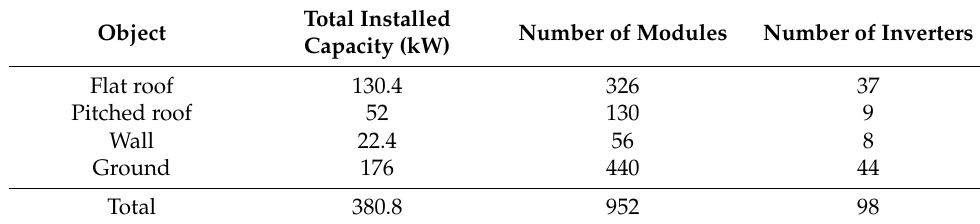
Table 1. Information on the PV modules mounted on different objects. Total Installed Object Number of Modules Number of Inverters Capacity (kW) Flat roof 130.4 326 37 Pitched roof 52 130 9 Wall 22.4 56 Ground 176 440 Total